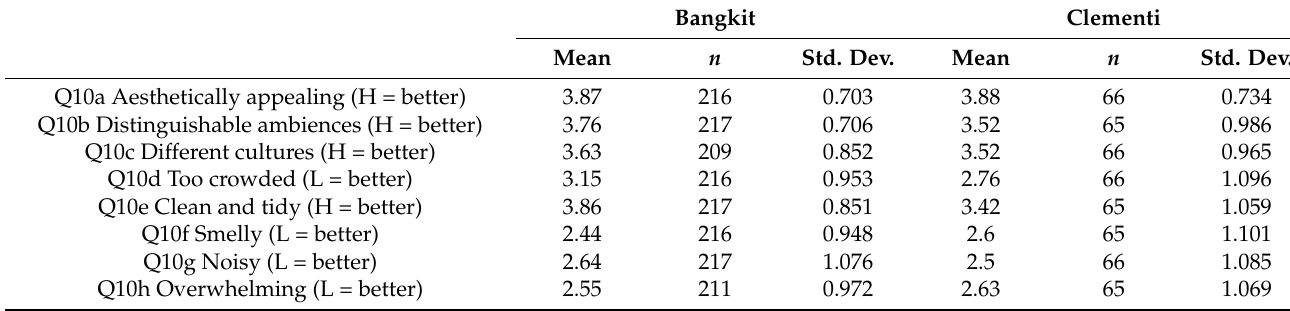
Table 9. Comparison of overall sensory appreciation assessment (Question 10 of Socio-sensory Survey, Appendix A). Bangkit